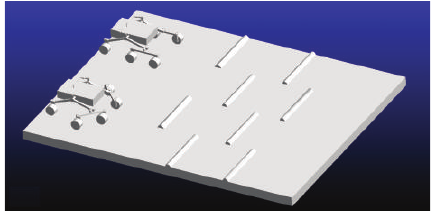
Figure 5: Kinematical simulation in scenario 1.